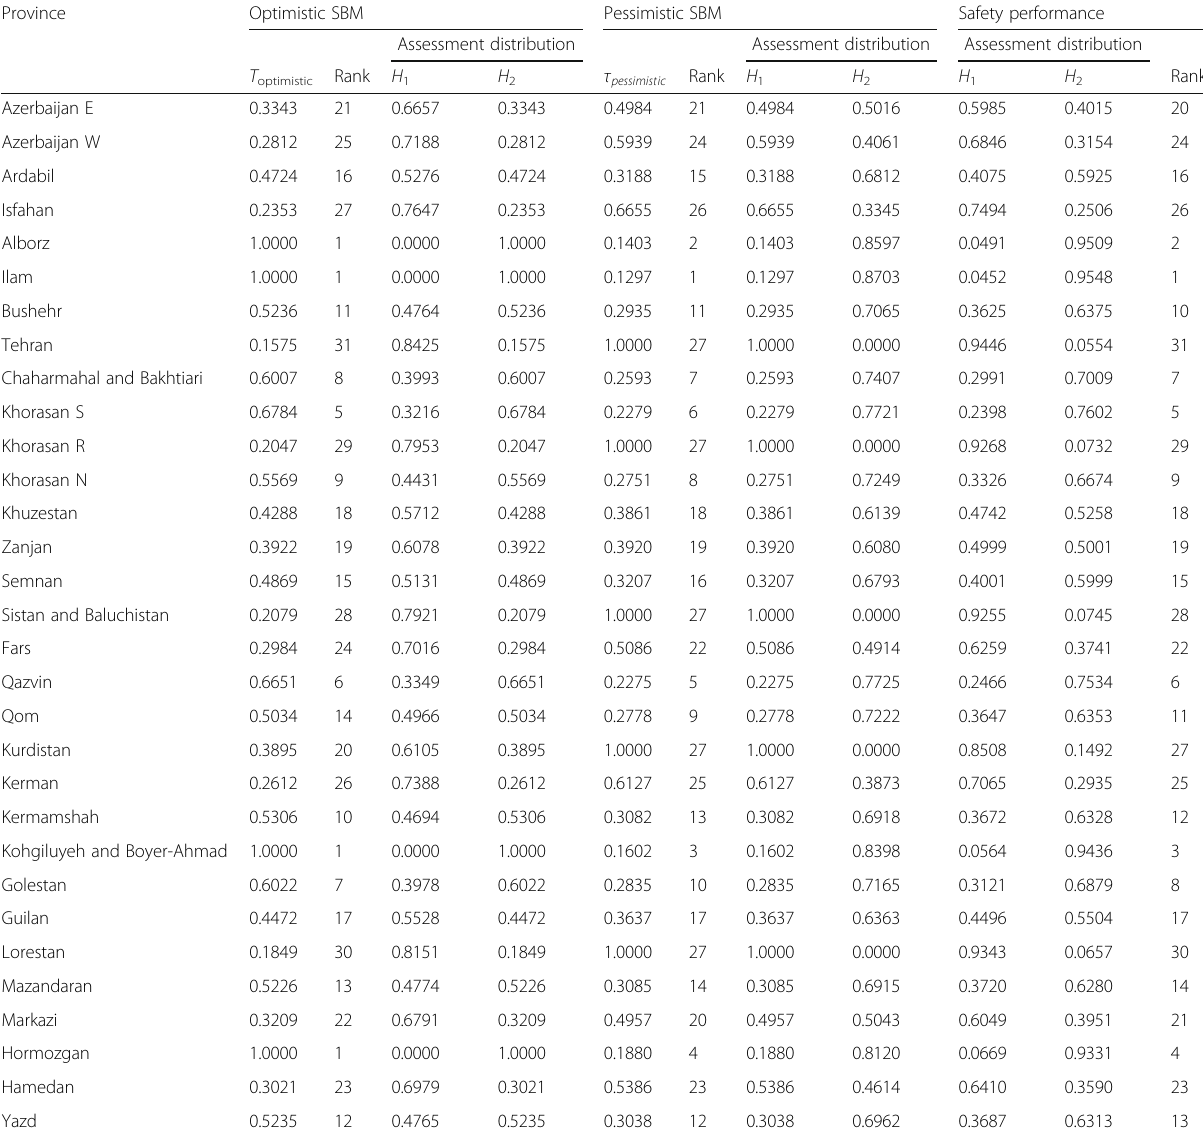
Table 5 Efficiency results for the 31 Iranian provinces in terms of road safety performance for the year 2016